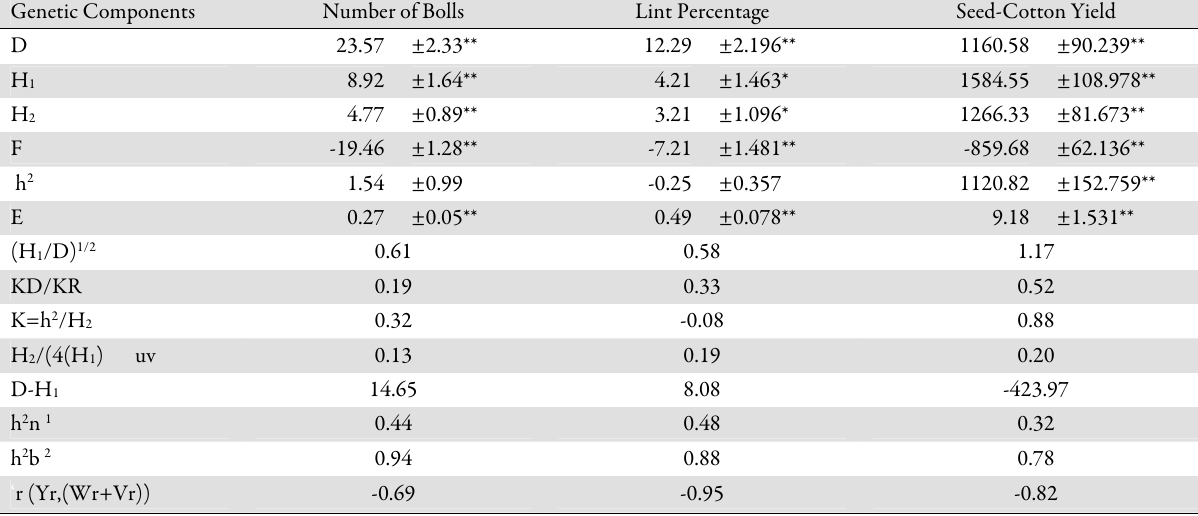
Table 5. Genetic components of variation for various traits in diallel crosses Genetic